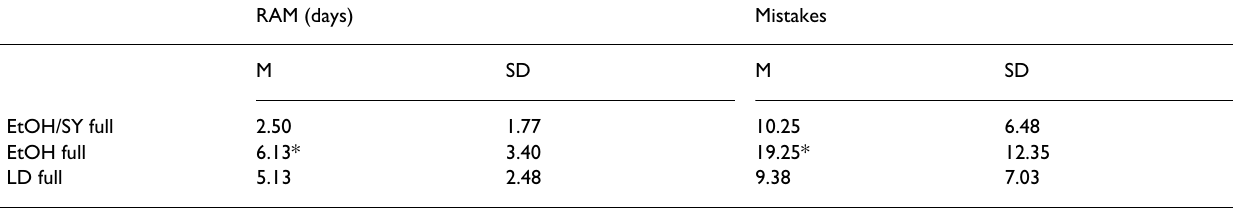
Table 3: Female Data for RAM Performance and Mistakes for selected full treatment groups.